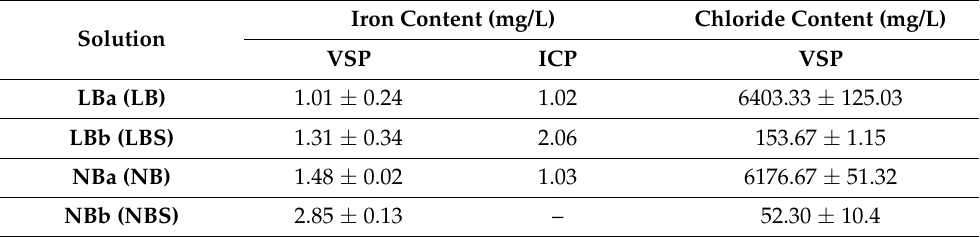
Table 3. Base values of iron and chloride content between traditional and the no salt variations of LB and NB and LBS and NBS, respectively, using Colour Vis Spectrophotometry (VSP) and Inductive Coupled Plasma-Optical Emission Spectroscopy